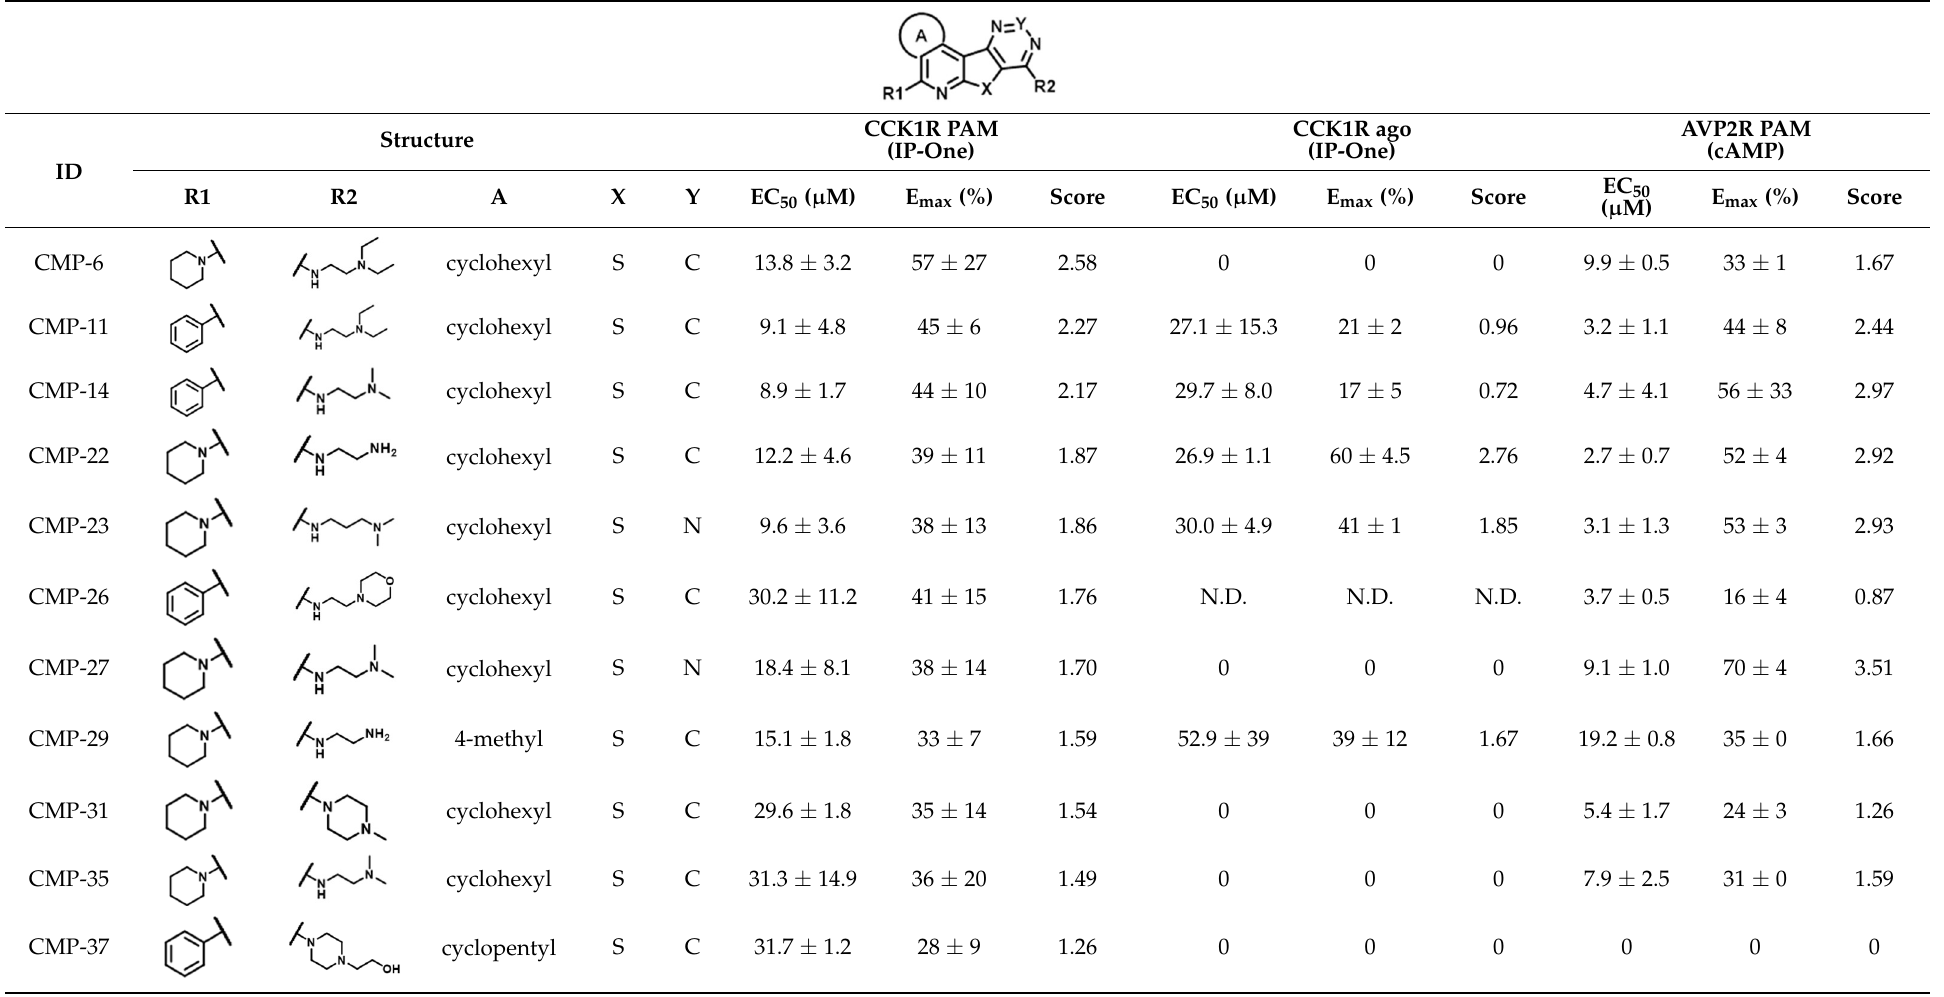
Average potencies (EC 50 ( µ M) ± standard deviation (SD)), average compound efficacy (E max (%) ± SD), and calculated activity score (E max × pEC 50 ) of compound dose–response Average potencies (EC 50 (µM) ± standard deviation (SD)), average compound efficacy (E max (%) ± Average potencies (EC 50 (µM) ± standard deviation (SD)), average compound efficacy (E max (%) ± studies in screening mode. Compounds were tested in Cisbio IP-One and cAMP accumulation assays; N.D. = not determinable (response less than mean ± 3 × SD of negative Average potencies (EC 50 (µM) ± standard deviation (SD)), average compound efficacy (E max (%) ± SD), and calculated activity score (E max × pEC 50 ) of compound dose–response studies in screening SD), and calculated activity score (E max × pEC 50 ) of compound dose–response studies in screening Average potencies (EC 50 (µM) ± standard deviation (SD)), average compound efficacy (E max (%) ± Average potencies (EC 50 (µM) ± standard deviation (SD)), average compound efficacy (E max (%) ± SD), and calculated activity score (E max × pEC 50 ) of compound dose–response studies in screening mode. Compounds were tested in Cisbio IP-One and cAMP accumulation assays; N.D. = not deter- mode. Compounds were tested in Cisbio IP-One and cAMP accumulation assays; N.D. = not deter- Average potencies (EC 50 (µM) ± standard deviation (SD)), average compound efficacy (E max (%) ± Average potencies (EC 50 (µM) ± standard deviation (SD)), average compound efficacy (E max (%) ± SD), and calculated activity score (E max × pEC 50 ) of compound dose–response studies in screening SD), and calculated activity score (E max × pEC 50 ) of compound dose–response studies in screening mode. Compounds were tested in Cisbio IP-One and cAMP accumulation assays; N.D. = not deter- minable (response less than mean ± 3 × SD of negative control). minable (response less than mean ± 3 × SD of negative control). Average potencies (EC 50 (µM) ± standard deviation (SD)), average compound efficacy (E max (%) ± SD), and calculated activity score (E max × pEC 50 ) of compound dose–response studies in screening SD), and calculated activity score (E max × pEC 50 ) of compound dose–response studies in screening mode. Compounds were tested in Cisbio IP-One and cAMP accumulation assays; N.D. = not deter- mode. Compounds were tested in Cisbio IP-One and cAMP accumulation assays; N.D. = not deter- minable (response less than mean ± 3 × SD of negative control). SD), and calculated activity score (E max × pEC 50 ) of compound dose–response studies in screening mode. Compounds were tested in Cisbio IP-One and cAMP accumulation assays; N.D. = not deter- mode. Compounds were tested in Cisbio IP-One and cAMP accumulation assays; N.D. = not deter- minable (response less than mean ± 3 × SD of negative control). minable (response less than mean ± 3 × SD of negative control). mode. Compounds were tested in Cisbio IP-One and cAMP accumulation assays; N.D. = not deter- minable (response less than mean ± 3 × SD of negative control). minable (response less than mean ± 3 × SD of negative control). minable (response less than mean ± 3 × SD of negative control).